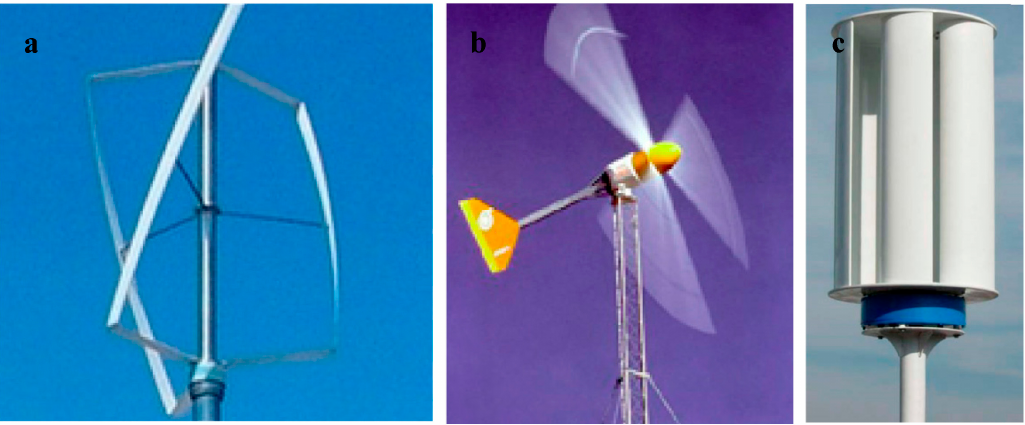
Figure 2. Different types of micro wind turbine: ( a ) Twisted H-Darrieus VAWT; ( b ) Three-blade propeller HAWT; ( c ) Savonius VAWT [24].